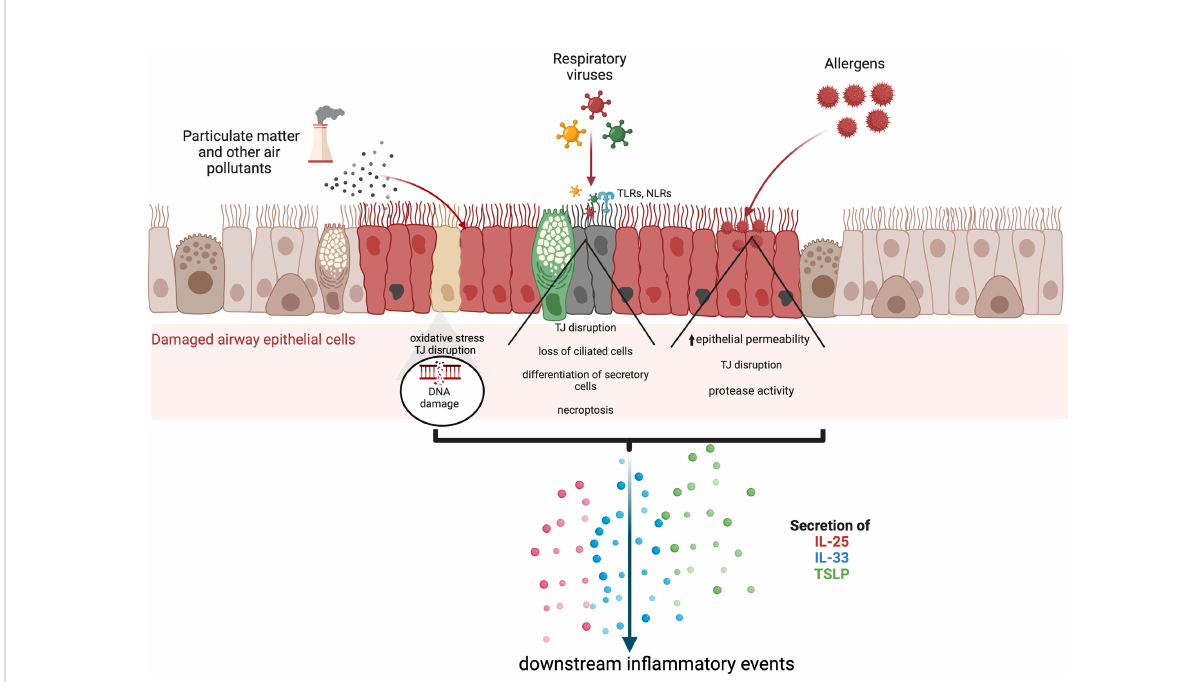
FIGURE 1 The secretion of alarmin cytokines in the airway epithelium may be triggered through multiple mechanisms which depend on the nature of the external insult. Asthma exacerbations can occur in response to air pollutants, allergens, and respiratory viruses. Various studies based on in vitrochallenged human bronchial epithelial cells and animal models indicate that IL-25, IL-33 and TSLP are released through cleavage of tight junctions (TJ), and necroptosis. Particulate matter and other air pollutants can trigger oxidative stress and the release of reactive oxygen and nitrogen species as well as DNA